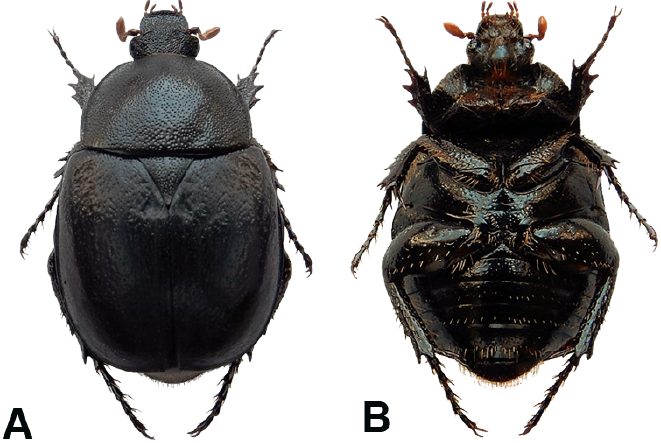
Fig. 3. Neoclita pringlei gen. et sp. nov., paratype, ♀, total length = 16.8 mm. A . Habitus, dorsal view. B . Habitus, ventral view. (South Africa, Eastern Cape Province, Matatiele Nature Reserve, 6 Dec. 2008, R. Perissinotto and L. Clennell leg.)